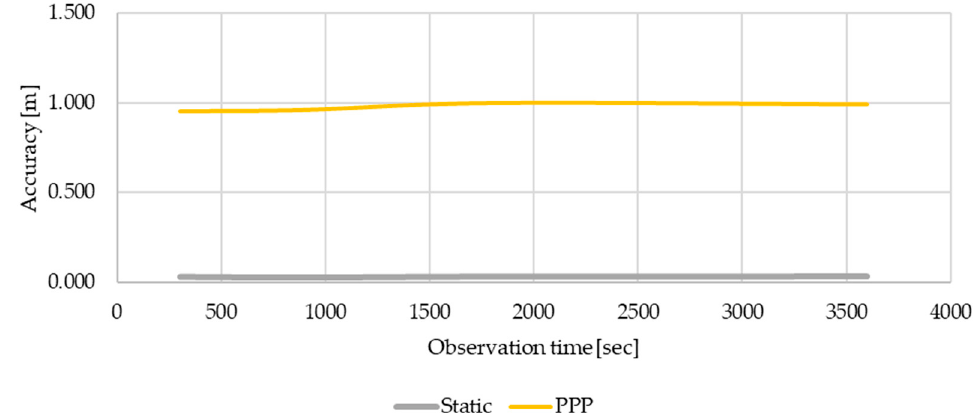
Figure A4. Accuracy in static 3D post-processed positioning in static mode (grey) and in PPP mode (yellow) of the G > S > P Sys. (yellow) of the G > S > P Sys.